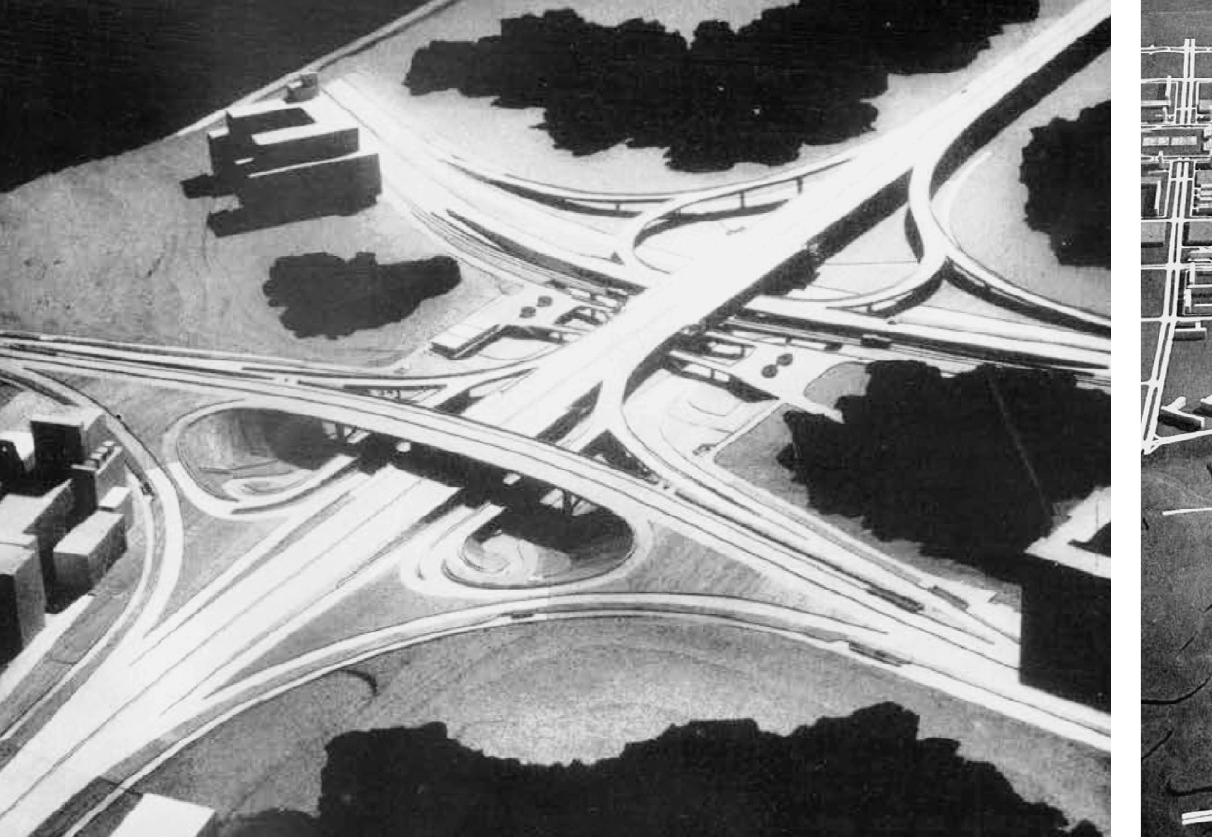
Fig. 4 Detail maquette of Mostar’s Junction in Belgrade with the pedestrian plaza crossing the Highway and linking different topographic levels (Source: Urbanizam Beograda no.1 (1969): 4.)